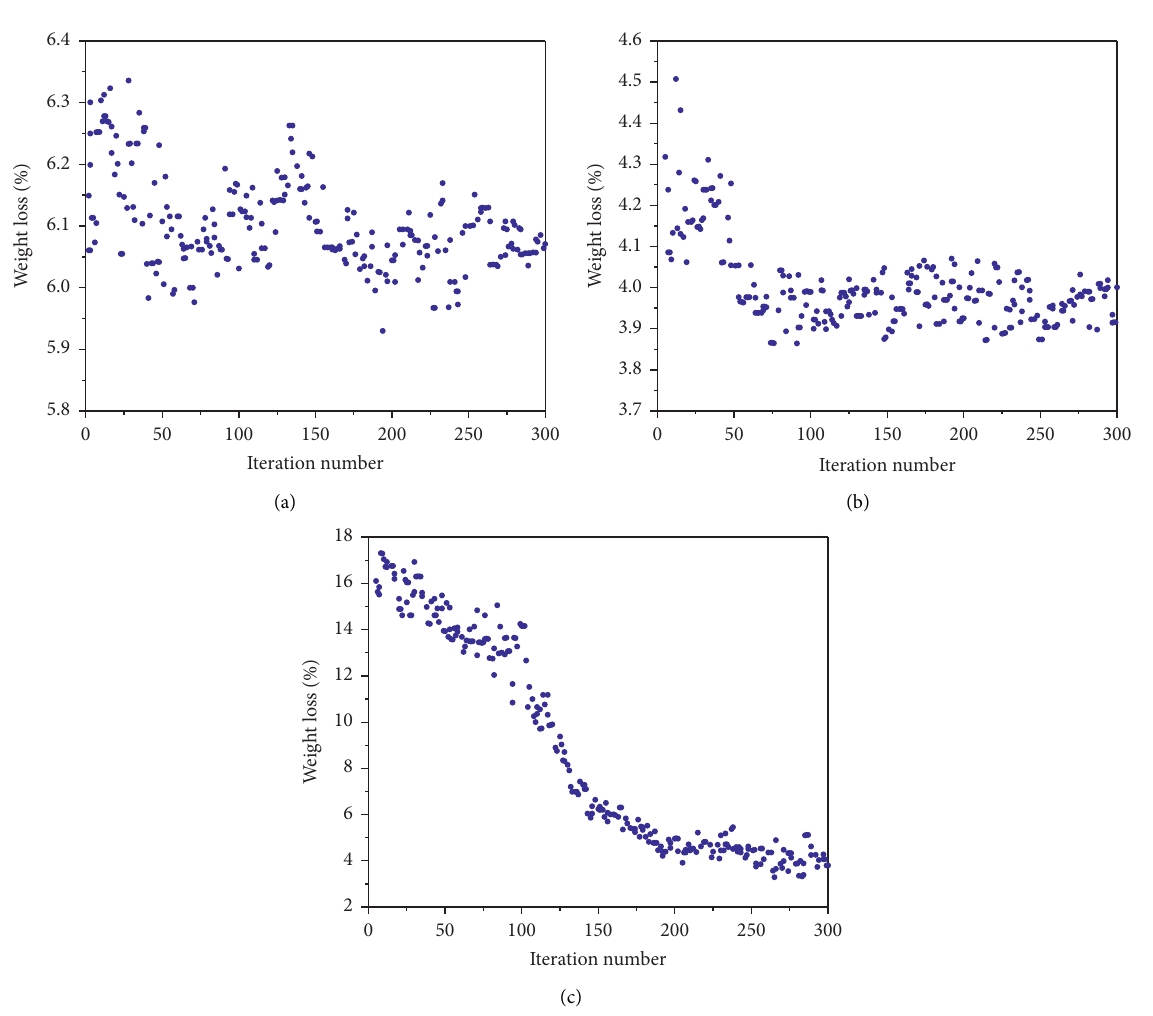
Figure 11: Relative dynamic modulus of concrete with triple-admixtures versus salt freeze-thaw cycles. (a) Air content of (2.5 ± 0.5)%. Table 8: The optimum variables obtained from the genetic algorithms.